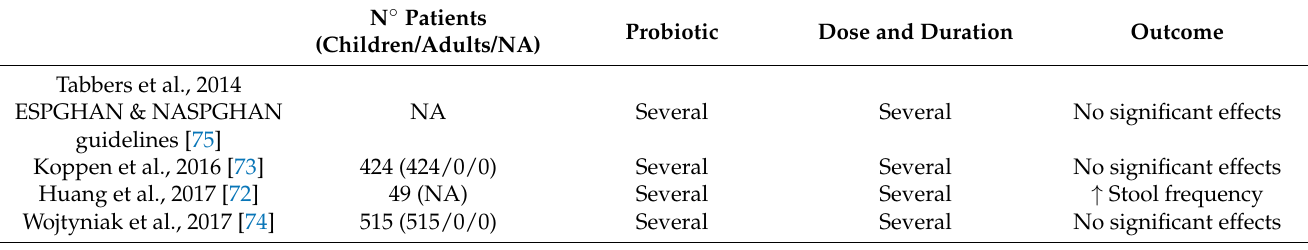
Table 9. Meta-analyses and systematic reviews on probiotics in functional constipation. N ◦